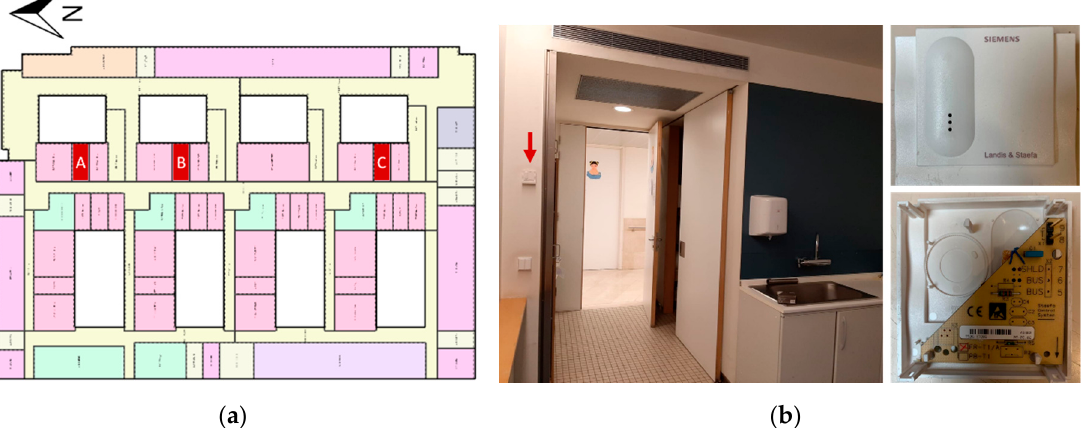
Figure 1. The last floor of the building, selected for the study. ( a ) Rooms location on the plan from the model view; ( b ) indoor temperature sensor type and location in the rooms.